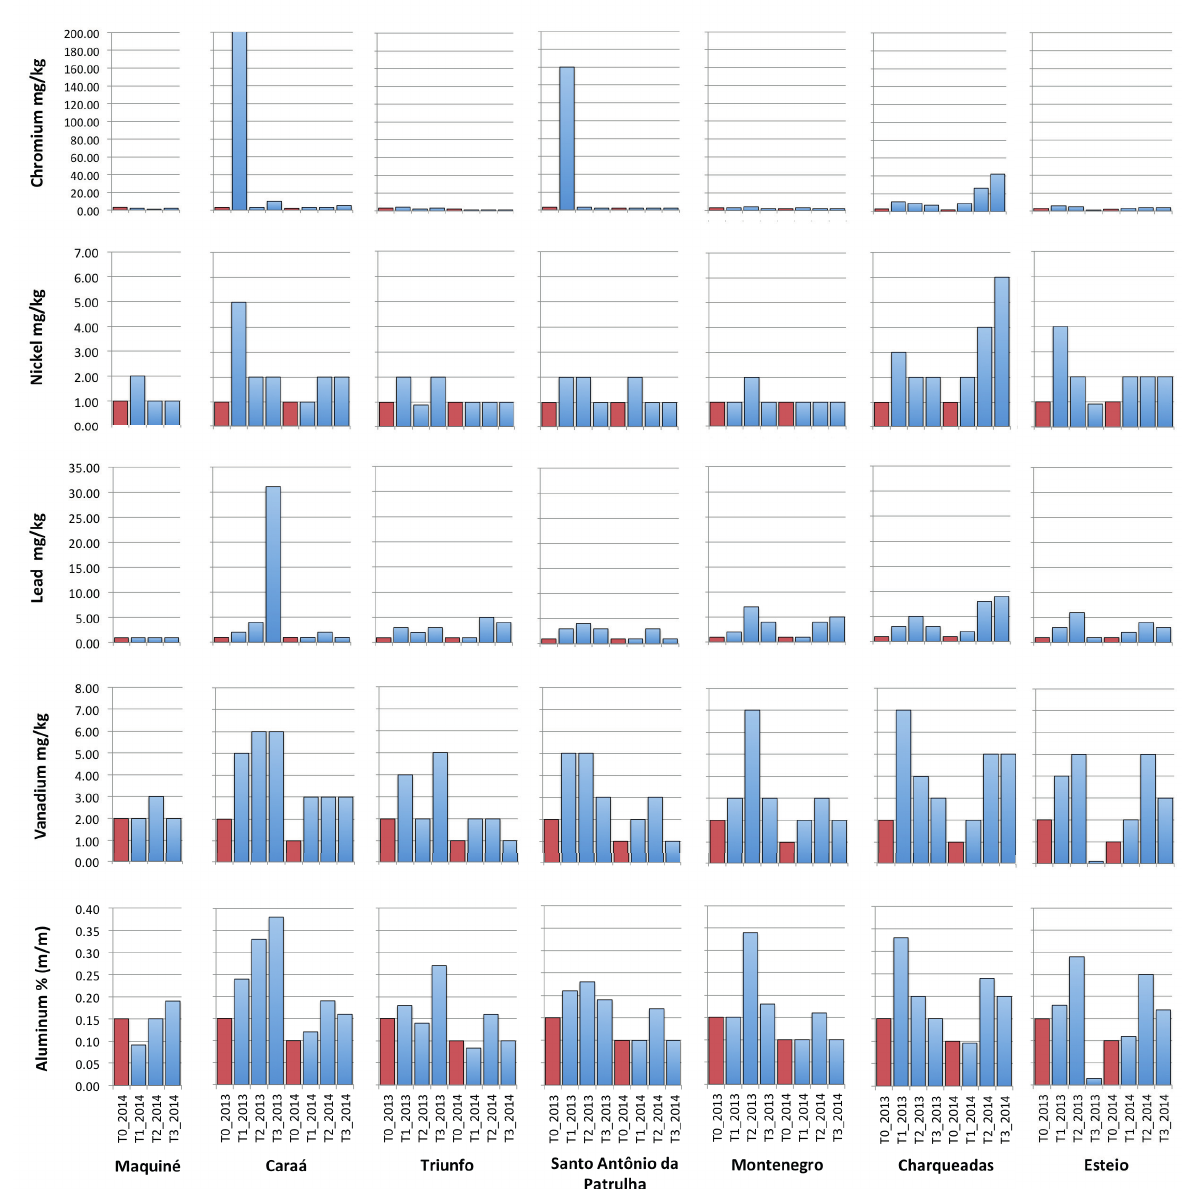
Figure 3 (continuation) - Contents of sulphur and metals absorbed by the lichen Parmotrema tinctorum during seven months of exposure in 2013 and 2014. The red column represents the basal values, prior to exposure in the cities. T0 = contents prior to exposure; T1 = after two months; T2 = after fi ve months; T3 = after seven